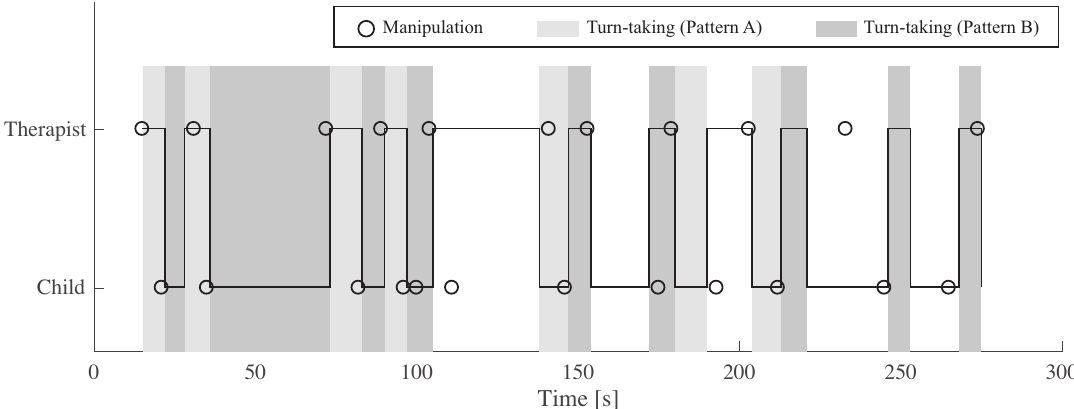
Figure 11. Marks represent the filtered data from the toys, and the shadowed areas the turn-taking (Pattern A and Pattern B) observed by one of the coders. This is an example of the results of the analysis on which it can be seen how the sensor’s data overlap the turn-taking intervals indicated by human